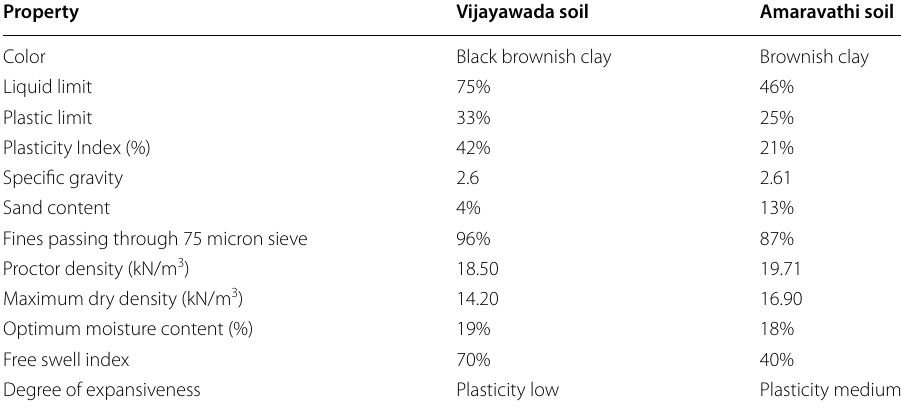
Table 2 Index properties of selected soil